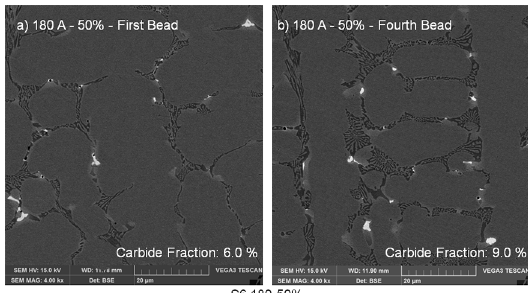
Figure 8. Typical coatings microstructure: 180 A, 50 %